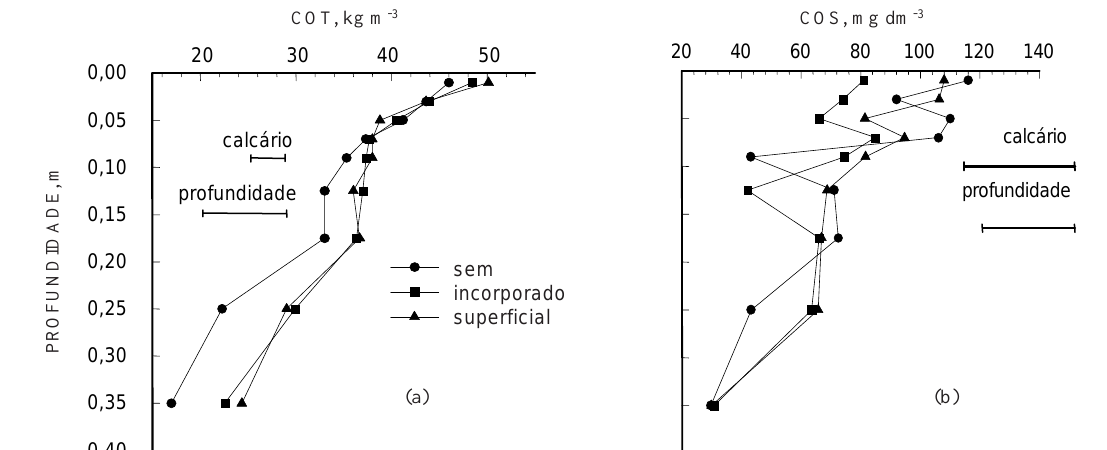
Figura 2. Teores de carbono orgânico total - COT (a) e carbono orgânico solúvel - COS (b) de um Latossolo Bruno alumínico em plantio direto, considerando três tratamentos de calagem (sem calcário, calcário incorporado e calcário superficial). Barras horizontais representam a diferença mínima significativa pelo teste de Tukey a 5 % (calcário = método de aplicação de calcário, profundidade = profundidade amostrada do